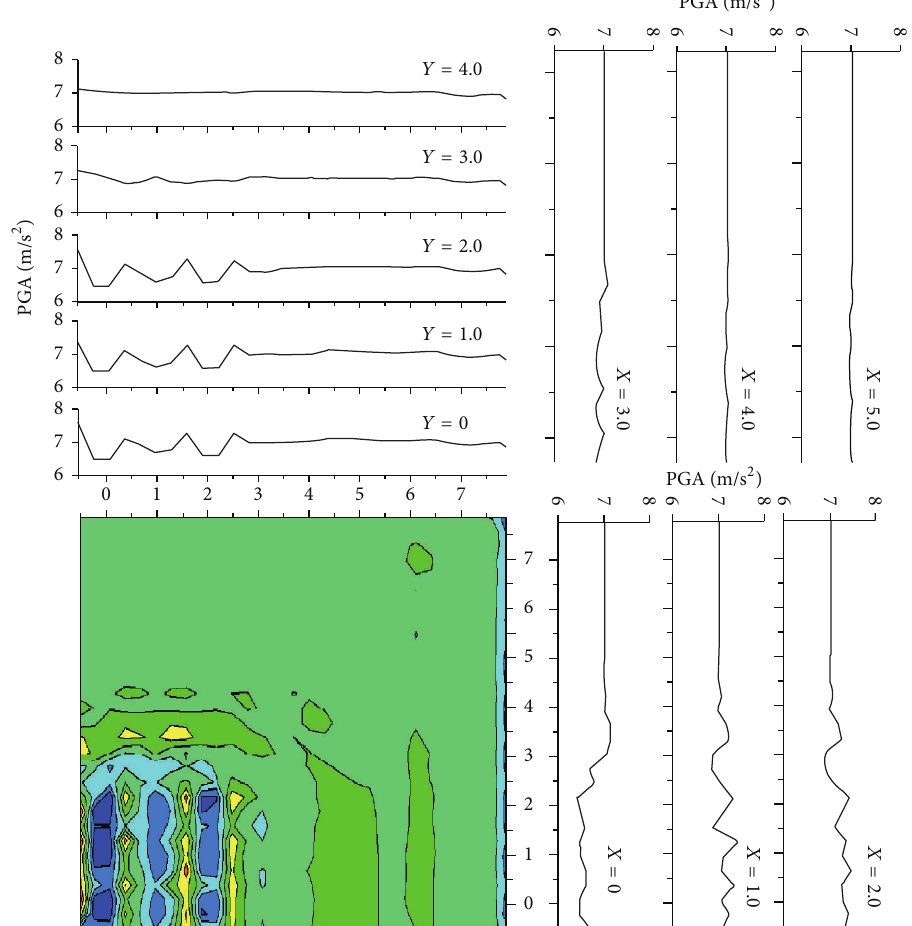
Figure 22: Peak ground acceleration distribution of URBAN6-6 with respect to nondimensional spatial coordinates (1/4 FE model, 𝐷 = 1.25 , El Centro, 𝑆𝑋 . The structure location is (0,0) , (0,1) , (0, 2) , (1,0) , (1, 1) , (1,2) , (2, 0) , (2,1) , and (2,2) . The urban nondimensional width is 6.0; the nondimensional effective width of the structural group parallel to the excitation is 11.0; the nondimensional effective width of the structural group perpendicular to the excitation is